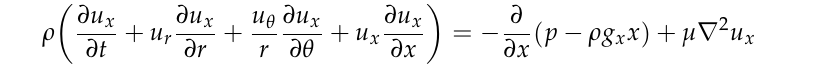
The Navier–Stokes equation projected onto the x -axis in the column coordinate system can be written in the following form